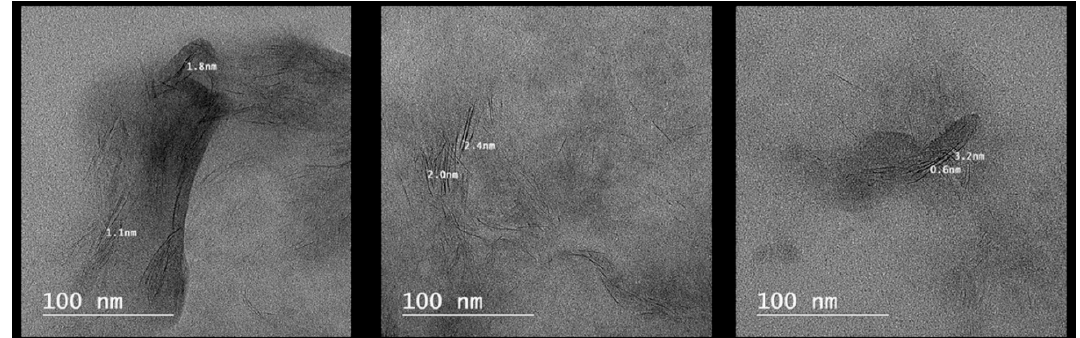
Figure 5. TEM images recorded on the polymethacrylic acid (PMAA)–Salecan xerogel matrix—sample PCS3.